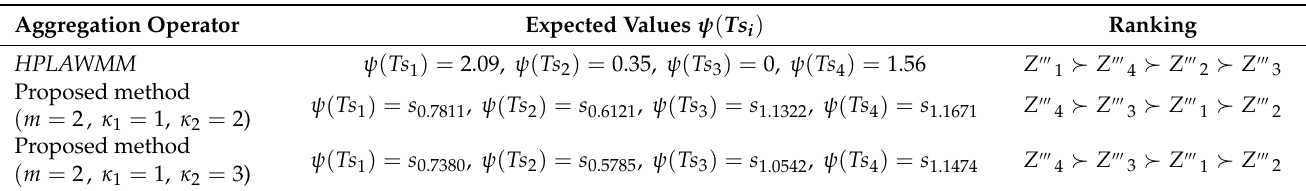
Table 7. Comparison of two